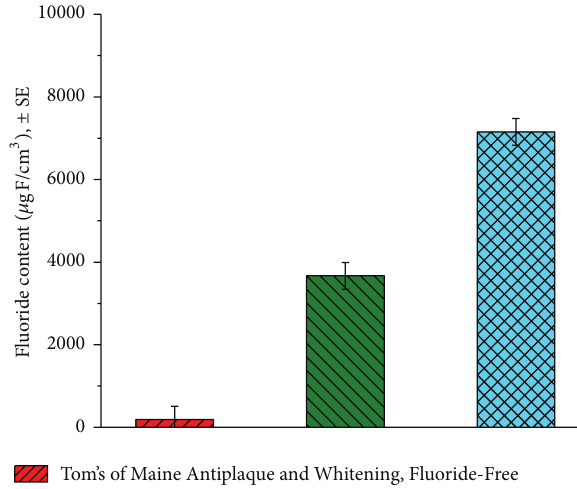
Figure 3: Change in surface microhardness (after baseline) ( 𝑛 = 18 specimens per group).